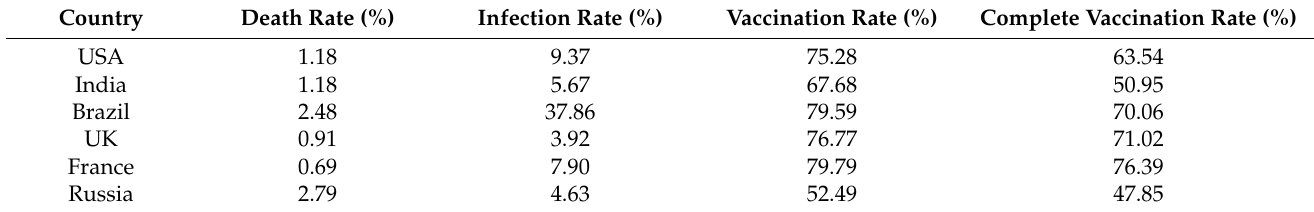
Table 1. Death rate, infection rate, vaccination rate and complete vaccination rate in six countries.